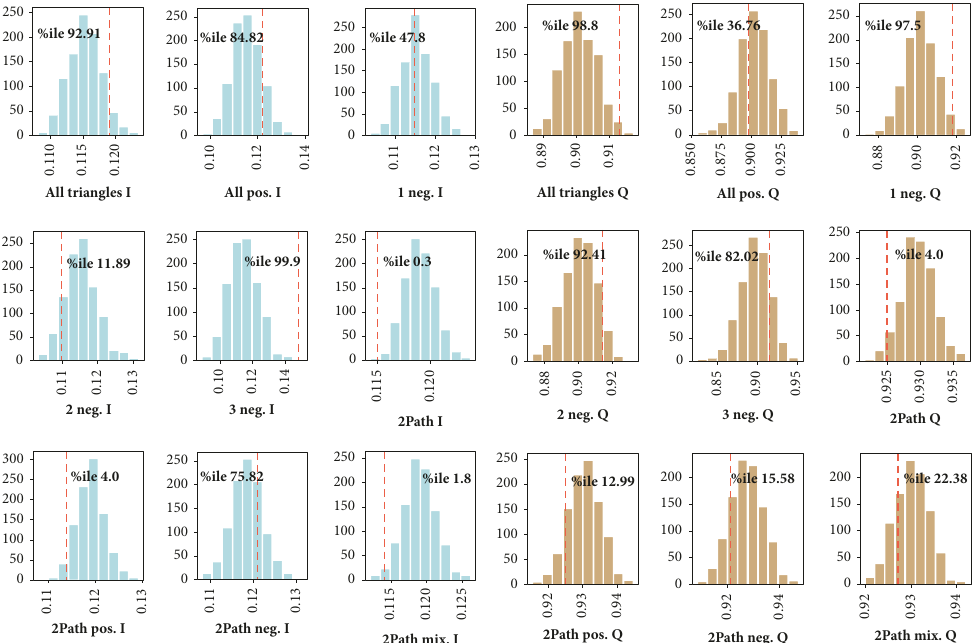
Figure 13: Significance of motifs’ intensity and coherence: distributions of intensity (first three columns, colored blue) and coherence (last three columns, colored light brown) of all closed and open triads, 2paths, and signed motifs in 1000 random networks with same structure and weight distribution as empirical network, with its percentile